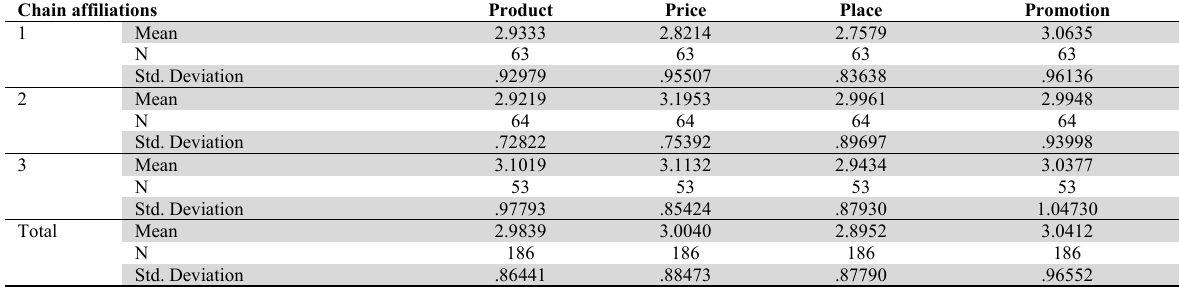
Table 5 Chain affiliations with (Product, Price, Place and Promotion) Chain affiliations